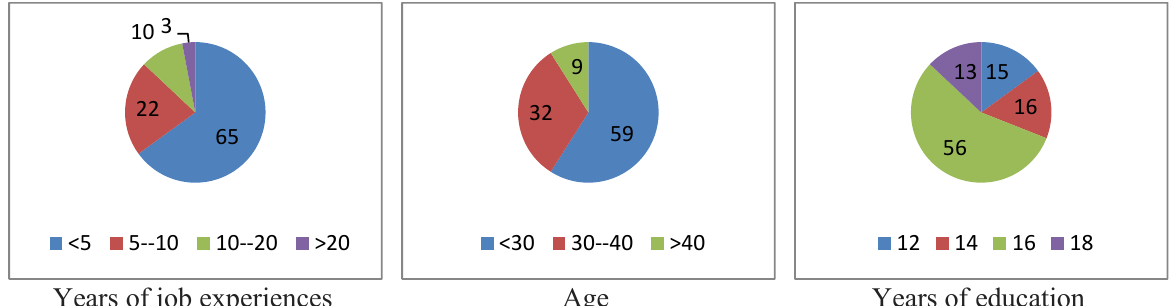
Fig. 1. The summary of job experience, age and years of